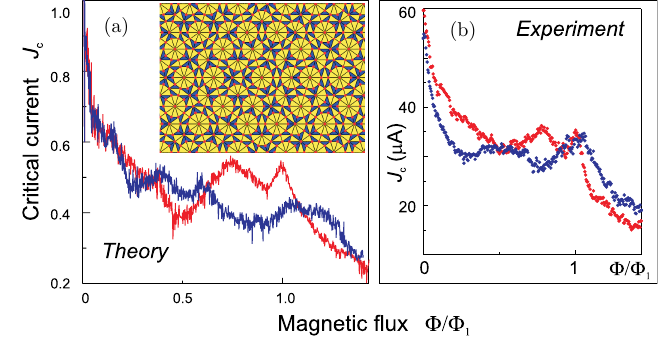
Fig. 2. Normalized critical current (experiment and theory), J c versus normalized magnetic °ux, (cid:3) = (cid:3) 1 ( / number of vortices N v ), for QP Tuebingen tiling. The function J c ð (cid:3) = (cid:3) 1 Þ for a ¯ve-fold Penrose-tiling APS is shown by red (gray) line, for comparison. The comparison shows that, while a ¯ve-fold Penrose- tiling APS provides a broad maximum for °uxes (cid:3) < (cid:3) 1 , in the case of a QP Tuebingen-tiling APS, the enhancement of the critical current is observed for magnetic °uxes (cid:3) > (cid:3) 1 . 86 For a detailed discussion and more results on other QP APS, see Refs. 76, 77,